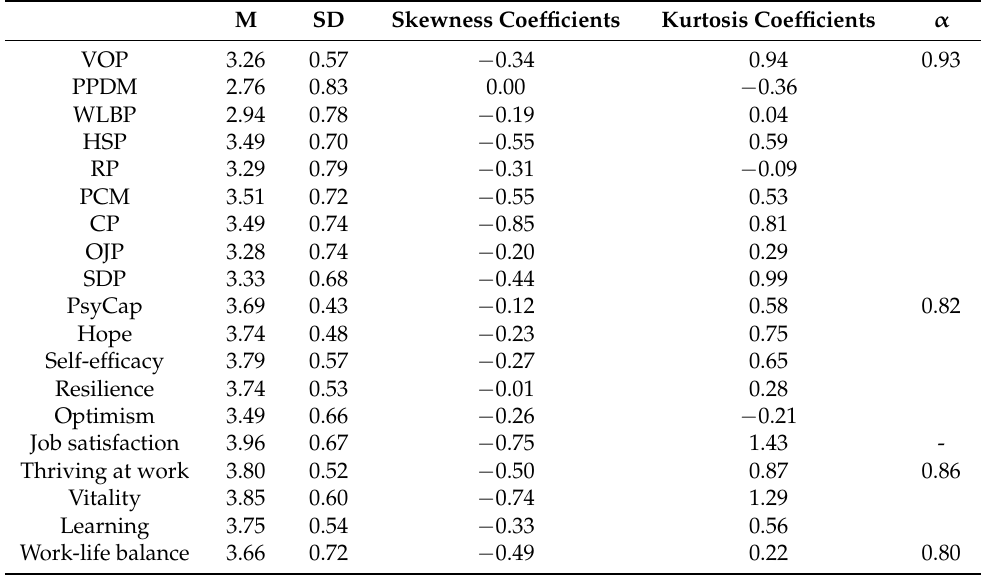
Table 1. Descriptive statistics for the study